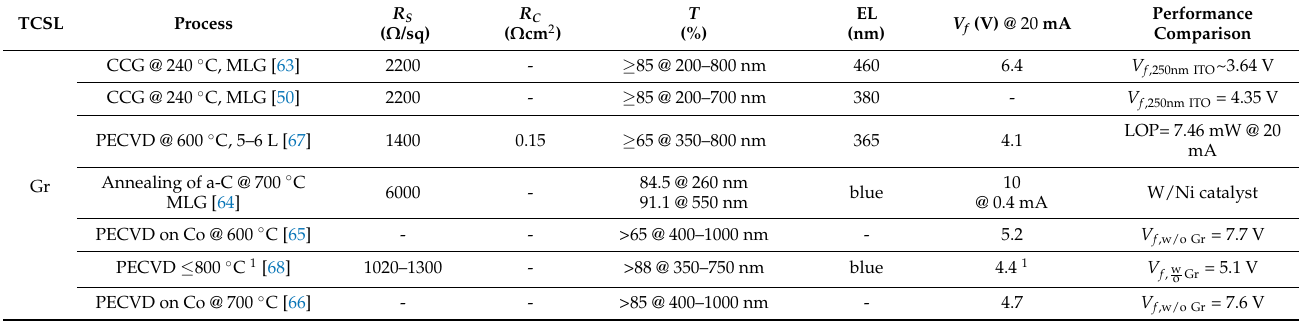
Table 2. Usage of directly grown graphene (Gr) TCSLs in GaN-based